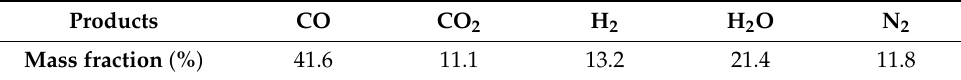
Figure 14. Temperature-time variation curve materials. Table 4. The propellant combustion products.